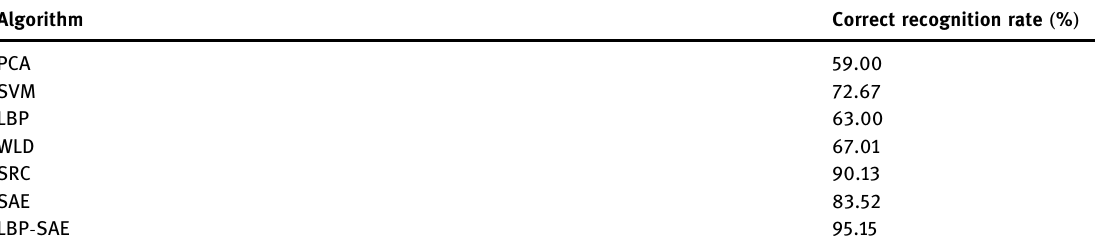
Table 1: Correct recognition rate of di ff erent algorithms on ExtendedYaleB library